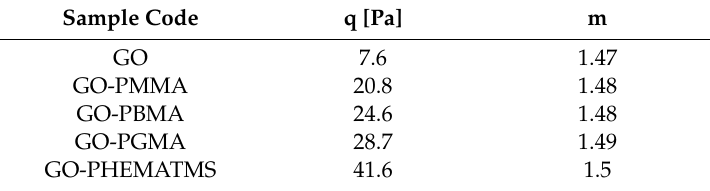
Figure 7. ( a ) Yield stress dependence on the electric field strength and ( b ) photoactuation capability by means of sample contraction, where: neat GO is ( □ ) and solid black line, GO-PMMA is ( ⊲ ) and orange dash-dot line, GO-PBMA is ( 〇 ) and blue dash-dot-dot line, GO-PGMA is ( △ ) and red dotted line and GO-PHEMATMS is ( ◊ ) and green dashed line. Table 3. Parameters of power-law model fits of neat and polymer modified GO particles